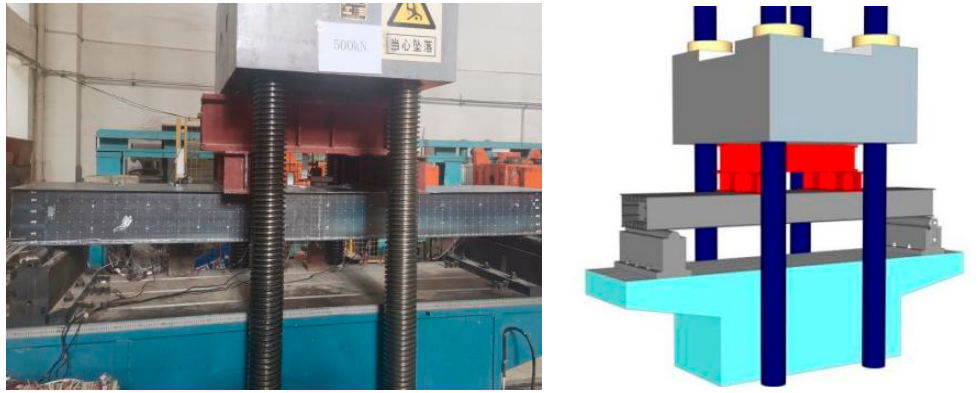
Figure 5. Loading device and schematic diagram of the specimen.